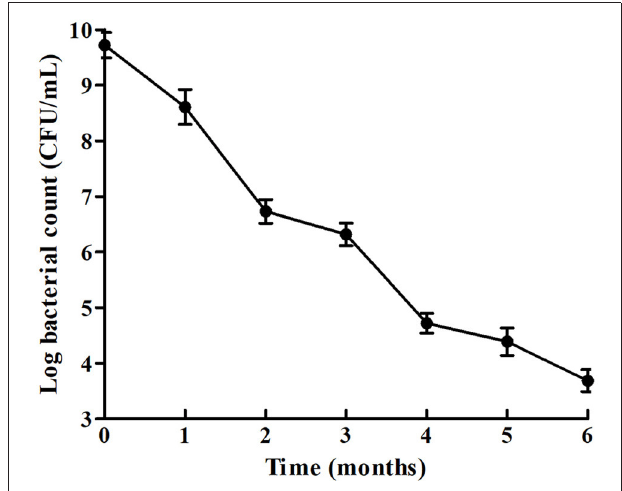
FIGURE 3 | Survival curves of V. anguillarum BH1 under starvation stress. Error bars: ± SD.